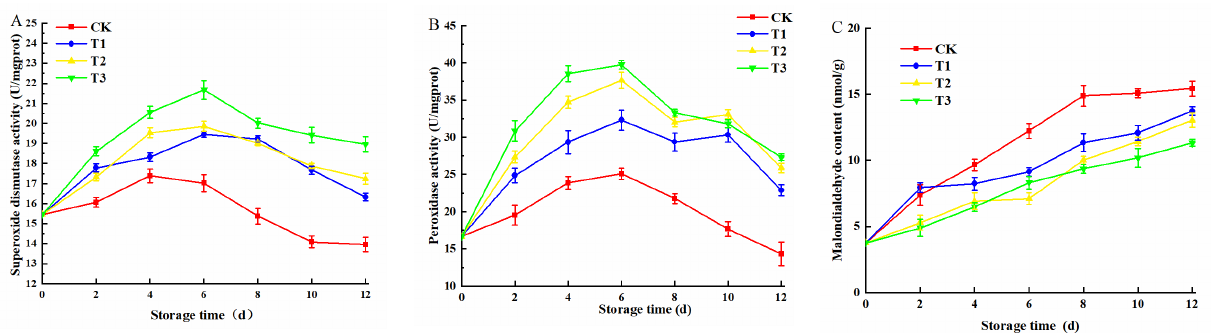
Figure 8. Effects of blue LED 460nm with different intensities on SOD activity ( A ); POD activity ( B ); and MDA contents ( C ) of freshly cut amaranth.